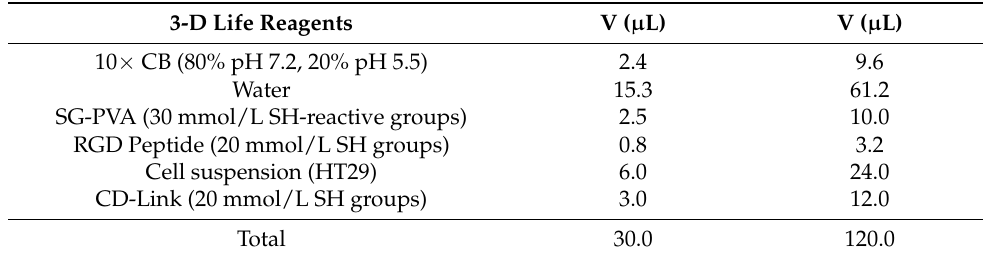
Table 1. Reagent volumes for 120 µ L gel for one